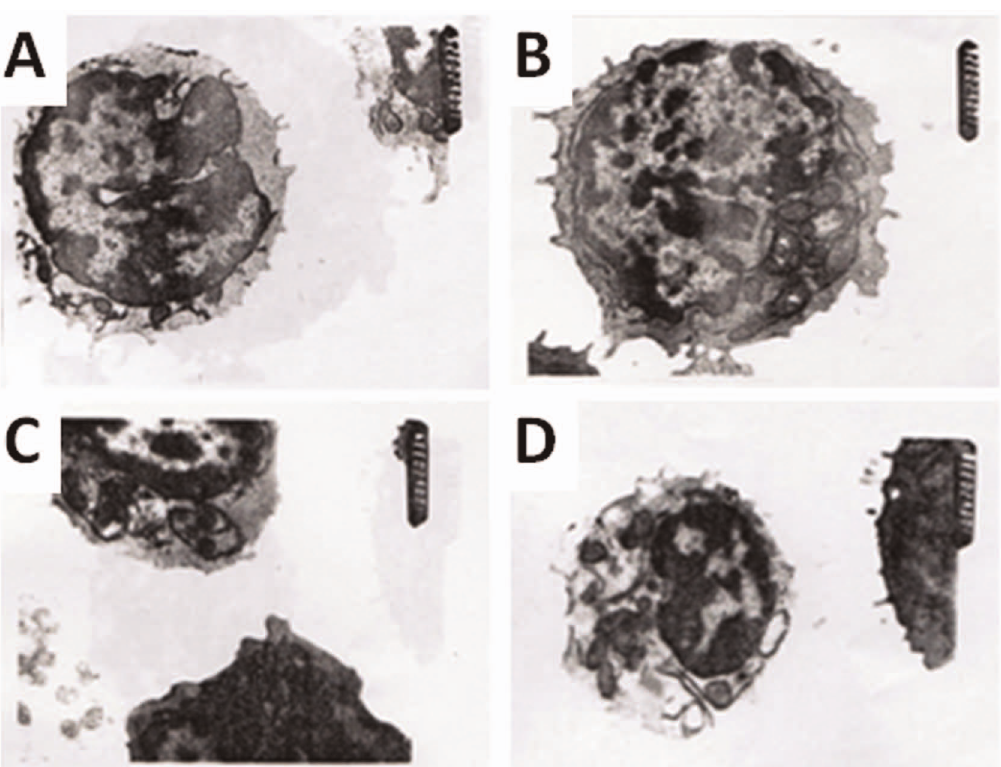
Fig. 4. The structure of lymphocytes in control group (a) and VMD patients showing swelling of mitochondria and deletion mitochondrial membrane phospholipids (b, c, d). (magnification 10,000X).